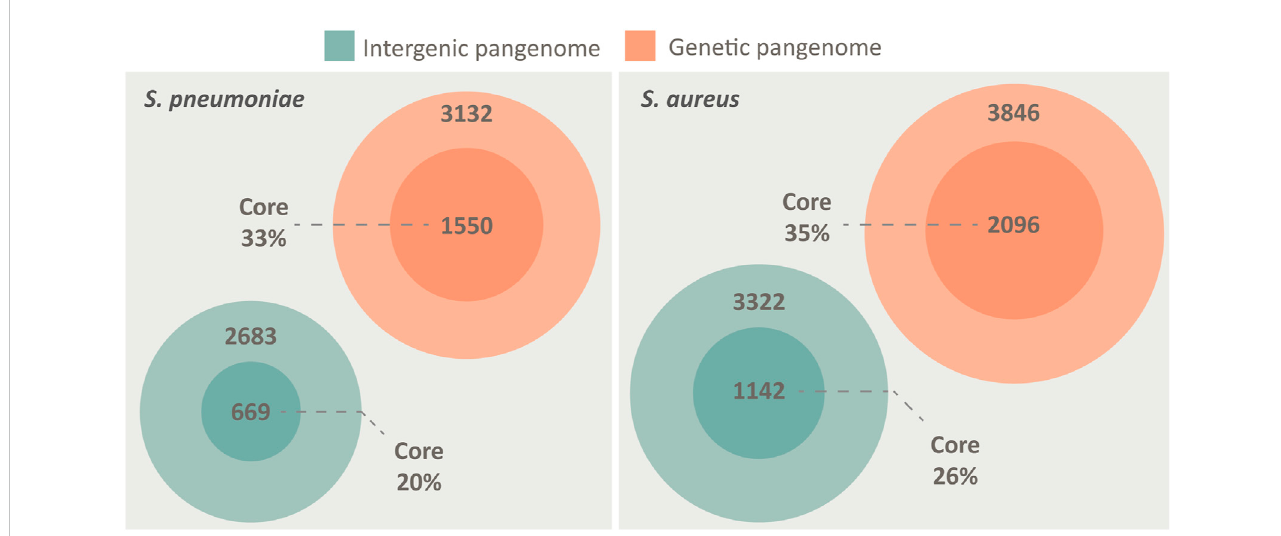
FIGURE 1 The pangenome of S. pneumoniae and S. aureus , spanning both intergenic regions (green) and genes (orange), illustrated by Venn diagrams. Both species possess a core genome of both IGRs and genes, de fi ned as being present in > 95% of isolates. The pangenomes are constructed from 84 unique genomes of each species. S. pneumoniae has a core genome of 1,550 genes and 669 IGRs, while an accessory genome of 3,132 genes and 2683 IGRs. S. aureus has a core genome of 2096 genes and 1,142 IGRs, while an accessory genome of 3,846 genes and 3,322 IGRs.